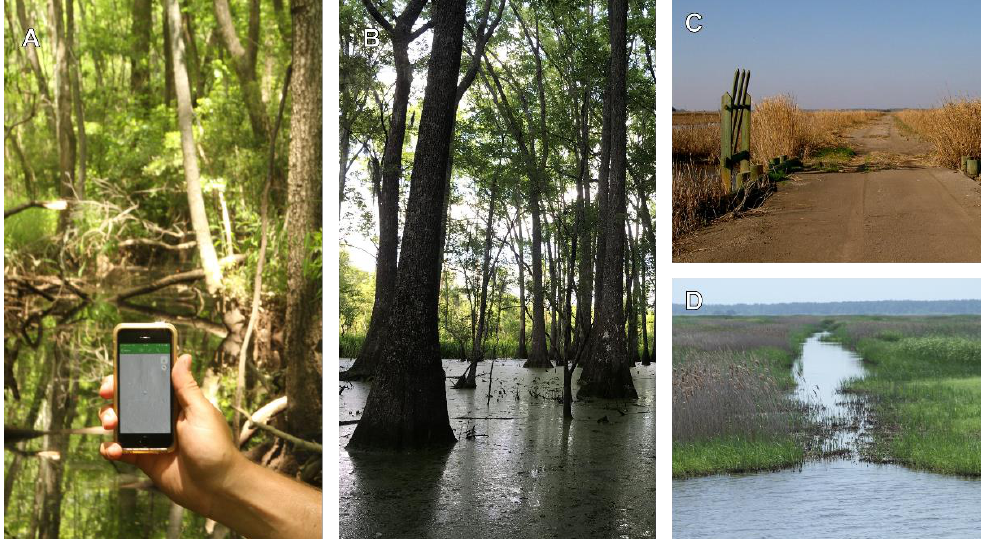
Figure 3. A subset of rice fields was selected to be field validated. ( A ) The AGOL application allowed for georeferenced field validation. A channel of an inland rice field is shown with the AGOL application in panel ( A ). Panel ( B ) demonstrates the dense overstory in many inland rice fields, where LiDAR-derived bare ground DEMs proved to be an invaluable data source. Panel ( C ) shows a dike of a tidal rice field. The wooden structure on the left side of the picture is a rice field trunk used as a water control feature. Panel ( D ) shows a quarter drain in a tidal rice field that is fully inundated. Photo credits: A, B, and D to D. Hanks. C to T. Folk.